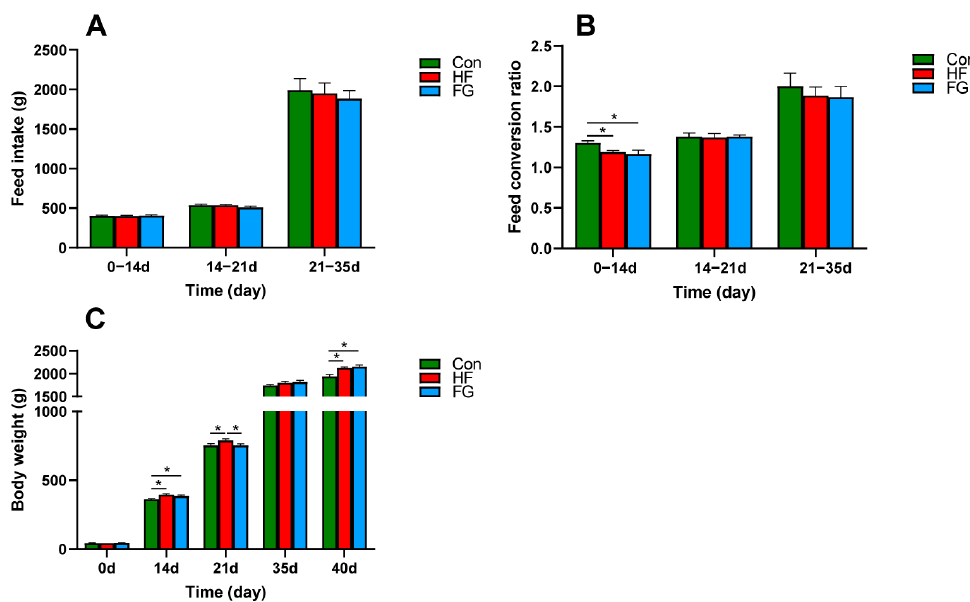
Figure 1. Effects of dietary fat level and GABA supplementation on feed intake ( A ), feed conversion ratio ( B ), and body weight ( C ). Data are presented as mean ± SEM, * p <